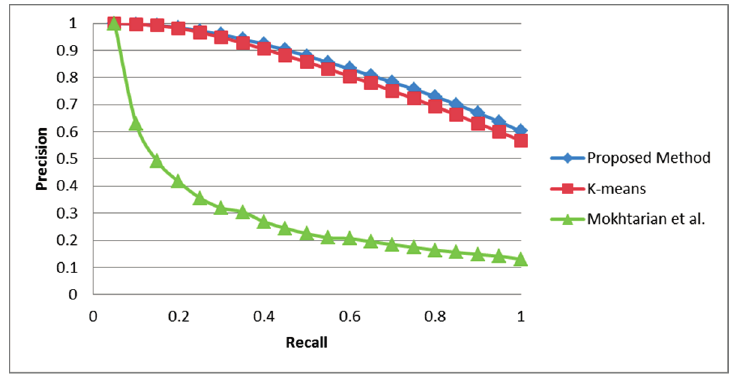
Figure 11. Average precision-recall curves of the proposed method, k -means and the automatic selection of optimal views proposed by Mokhtarian et al .